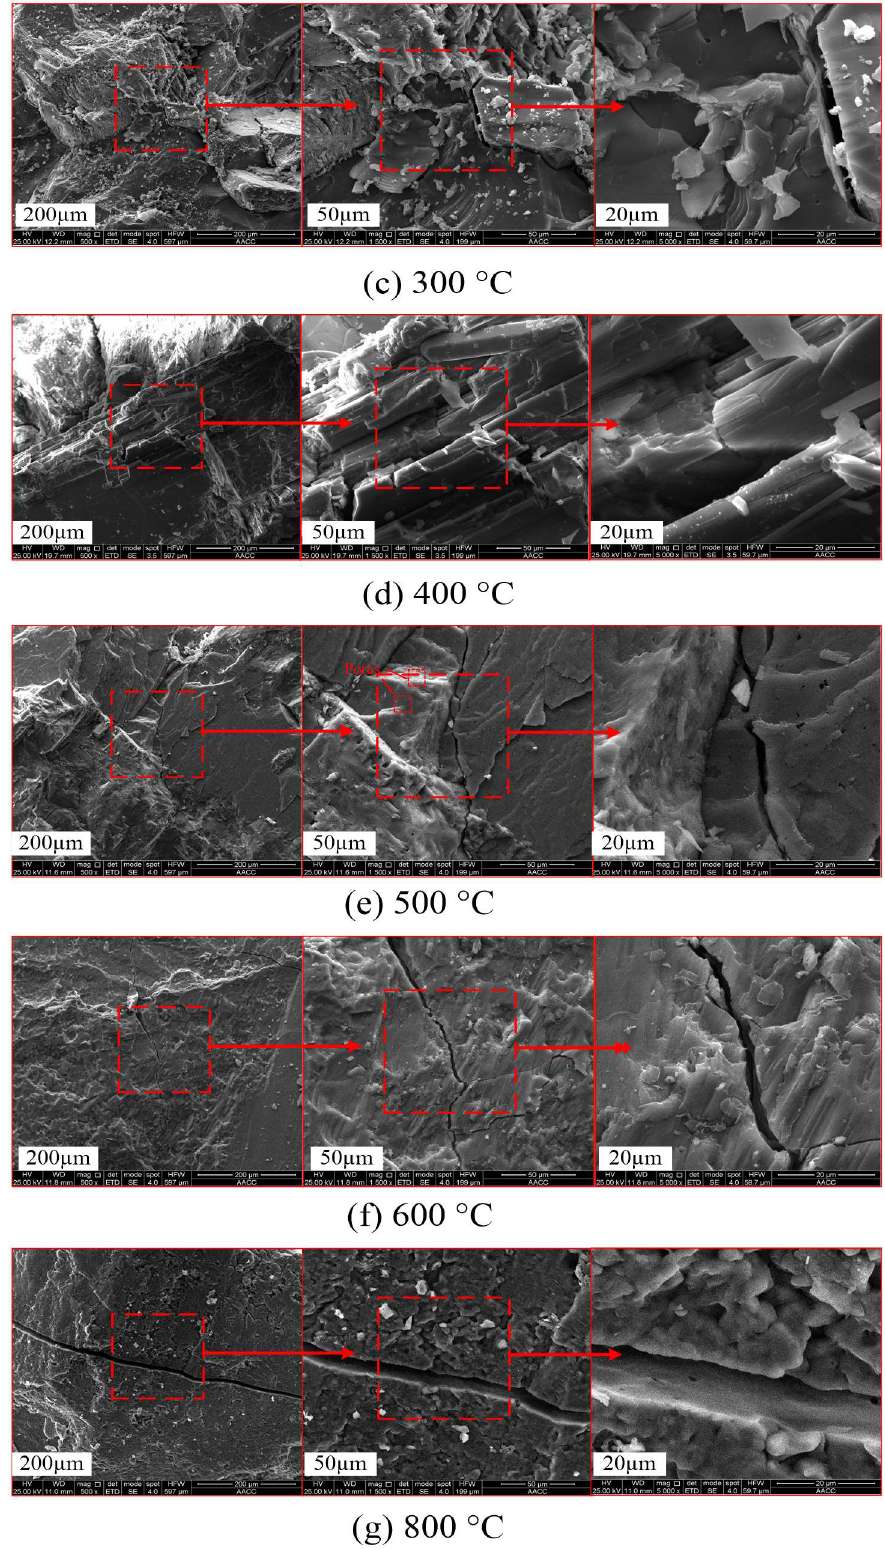
Figure 5. Scanning electron microscope (SEM) images of granites at room-temperature and after high-temperature exposure. ( a ) Room temperature; ( b ) 200 °C; ( c ) 300 °C; ( d ) 400 °; ( e ) 500 °C; ( f ) 600 °C; ( g ) 800 °C.